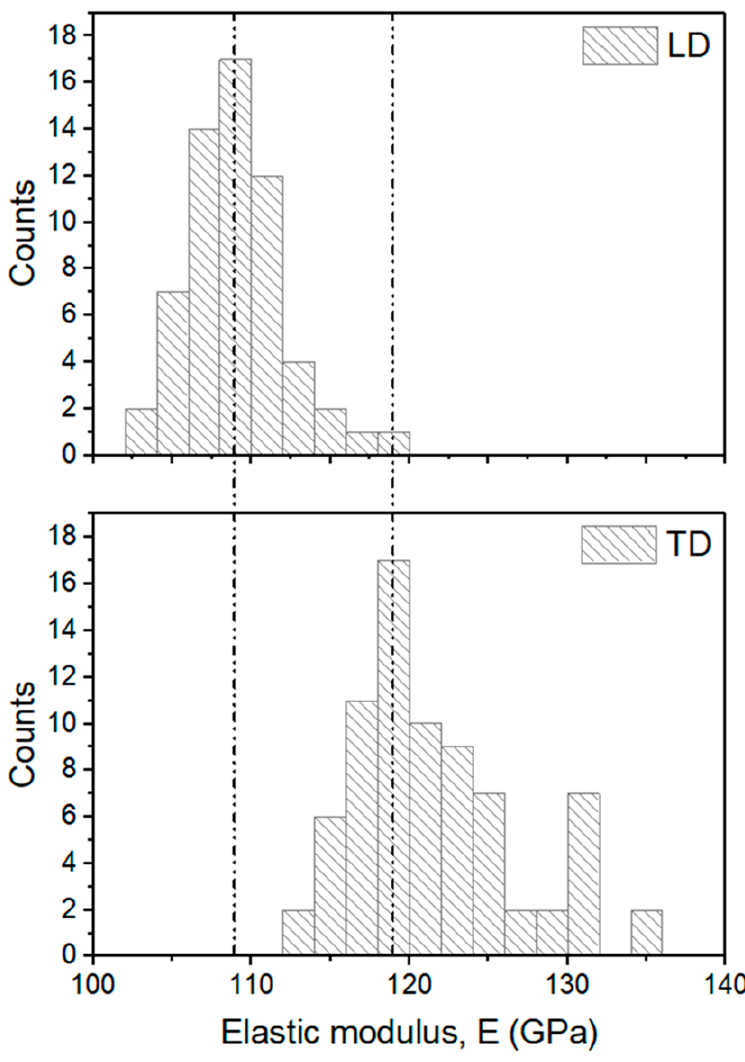
Figure 10. Elastic modulus histograms determined from 64 indents performed at constant displacement into the surface of 700 nm for both orthogonal directions (LD and TD).